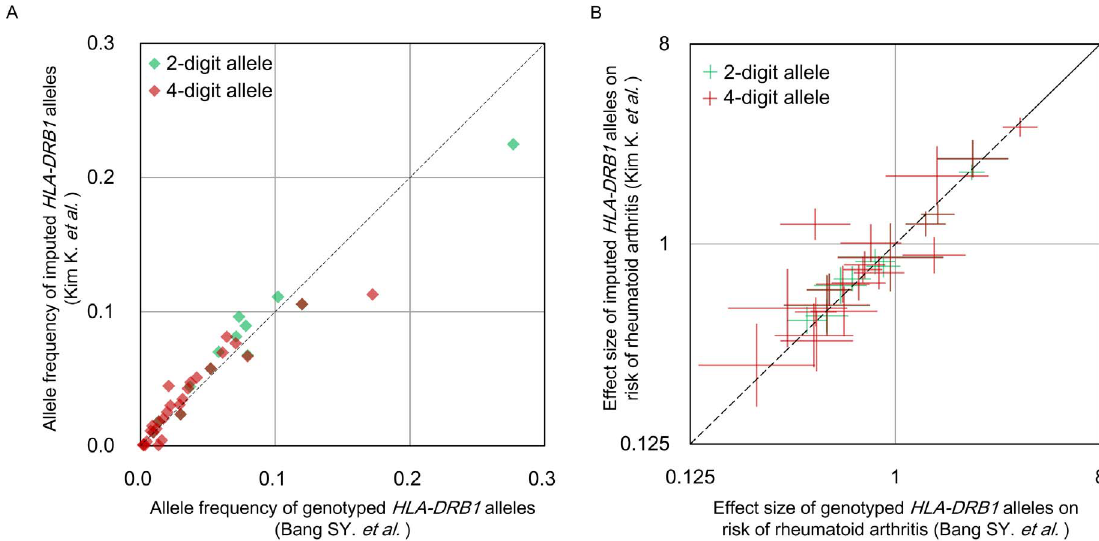
Figure 2. Frequencies and disease effect sizes of imputed and genotyped HLA-DRB1 alleles. We revisited our previous rheumatoid arthritis association studies using either typed SNPs [16] or HLA alleles [17]. After imputing HLA variants from the SNP-based dataset, (A) frequencies and (B) disease effect sizes of the imputed classical alleles of HLA-DRB1 were compared with those of genotyped classical alleles in the HLA-based dataset.